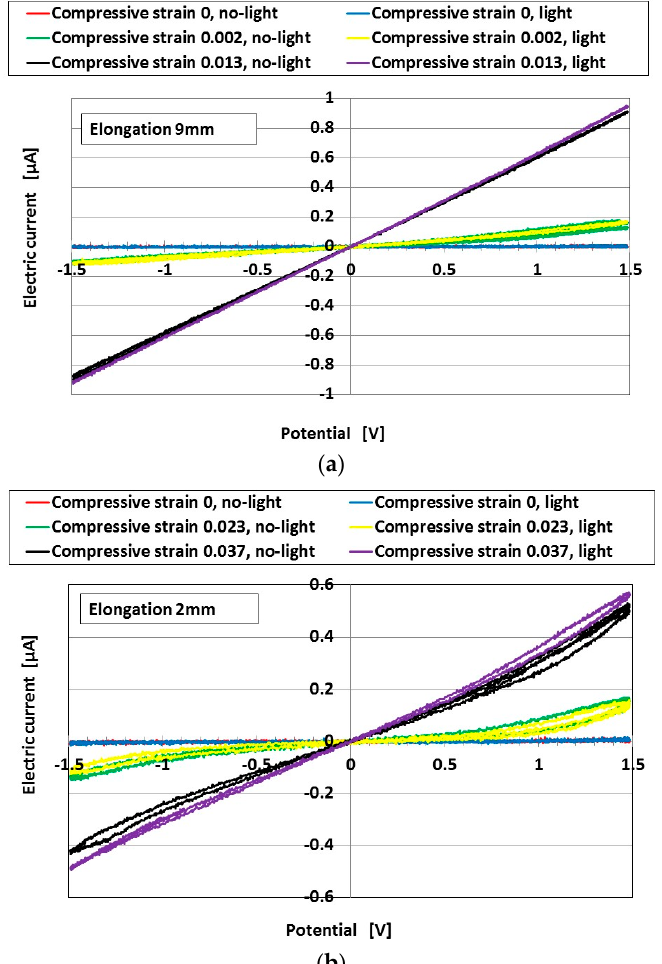
Figure 11. The effect of tension and compression on cyclic voltammetry plots measured by potentiostat at turning ultraviolet light on for wet-type MCF rubber solar cells electrolytically polymerized under a magnetic field with 0.22 g of Ruthenium complexes dye and 7.4 g of KI+I 2 electrolyte: ( a ) elongation of 9 mm; ( b ) elongation of 2 mm. The MCF rubber had 3 g of TiO 2 , 6 g of Ni, 4.5 g of MF, and 9 g of NR-latex. The irradiation light was ultraviolet (40 Lux). The used experimental apparatus and procedure was the same as those used in the second report [19].